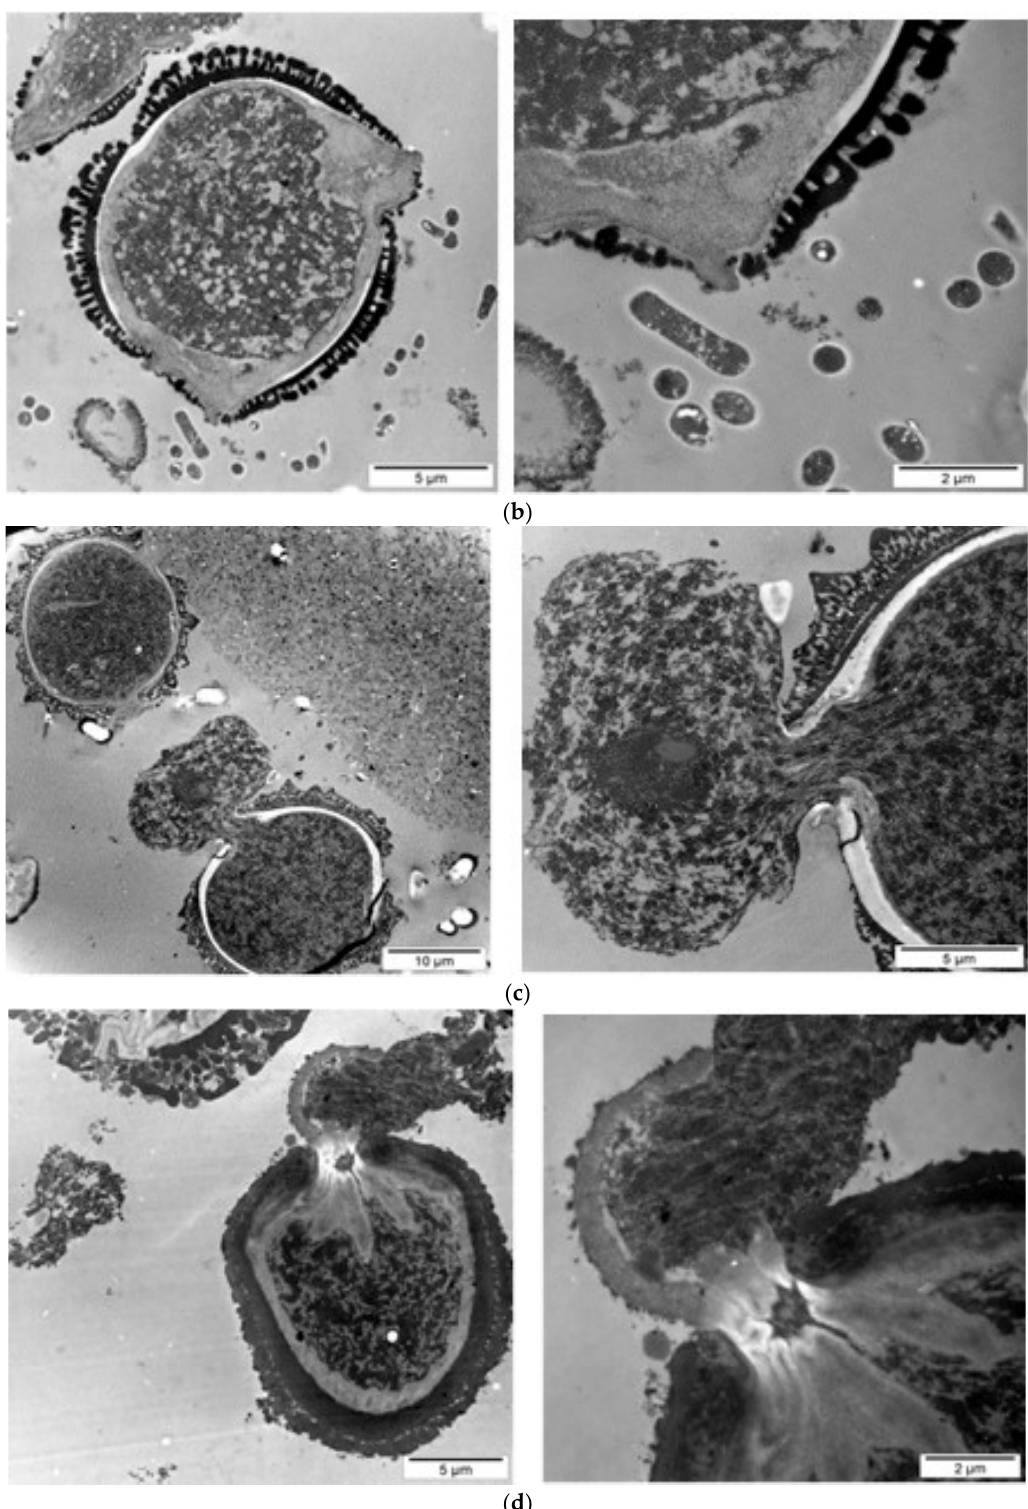
Figure 6. Fermented pollen in kombucha vinegar: ( a ) 3 days, ( b ) 5 days, ( c ) 7 days, ( d ) 9 days. There is a progressive dynamic of destruction of the pollen complex wall structure, starting both from exterior and interior of the pollen grain. TEM images show that there are visible modifications of the structural units of the pollen shells (external and internal pollen coating — exine and intine).